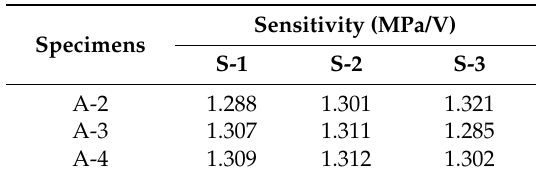
Table 1. Sensitivity of each